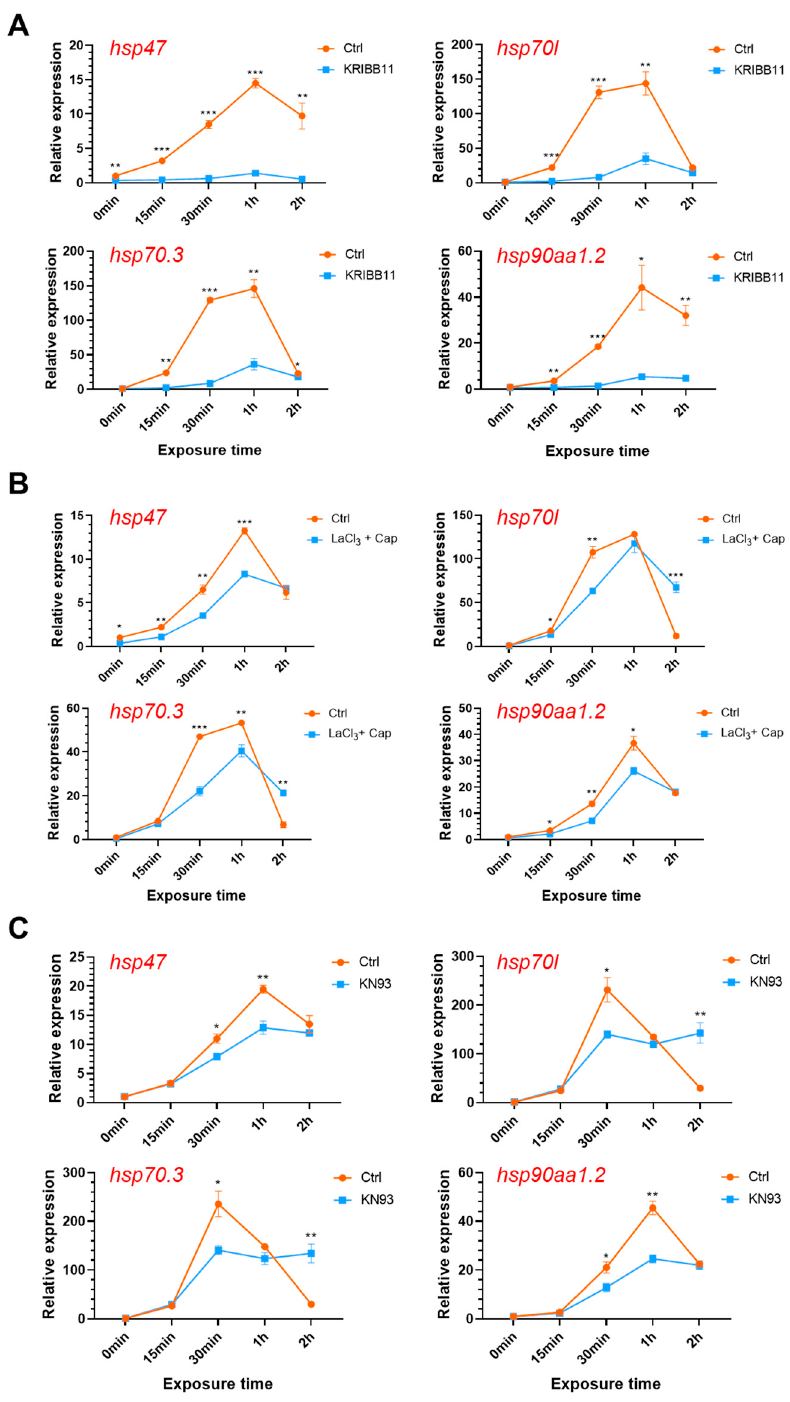
Figure 6. Effects of modulating the Ca 2+ -CaMKII-HSF1 pathway on expression of the hsp genes. Zebrafish larvae at 96 hpf were treated with the specific inhibitors for HSF1 ( A , 10 μ M KRIBB11), membrane calcium channels ( B , 0.2 mM LaCl 3 plus 5 μ M capsazepine) and CaMKII ( C , 10 μ M KN93 phosphate) before and upon exposure to 34 °C heat stress for indicated times. Data are shown as mean ± standard error ( n = 3). *, p < 0.05; **, p < 0.01; ***, p < 0.001.